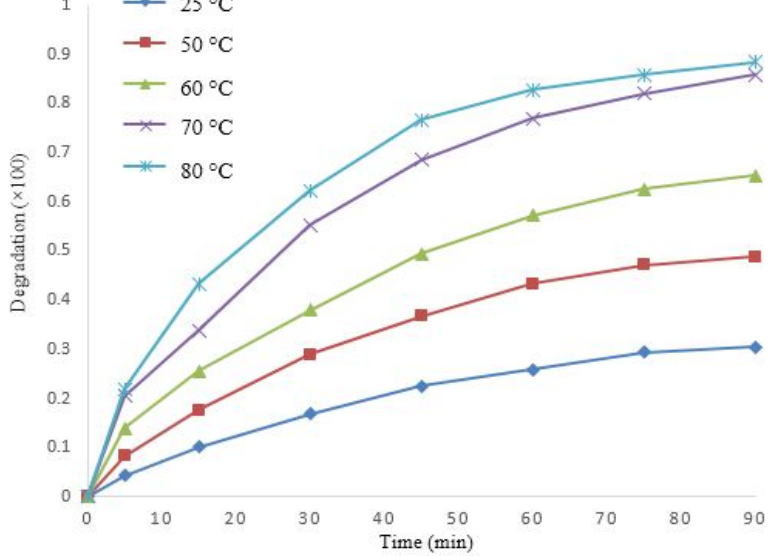
Fig. 12. Effect of Temperature on Catalytic Degradation of